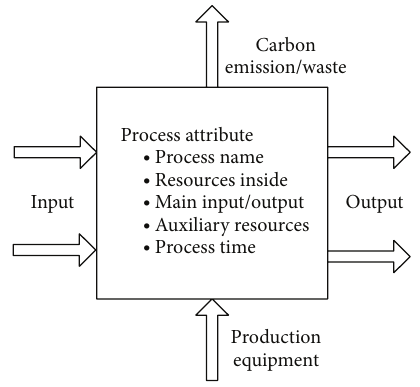
Figure 1: Basic process